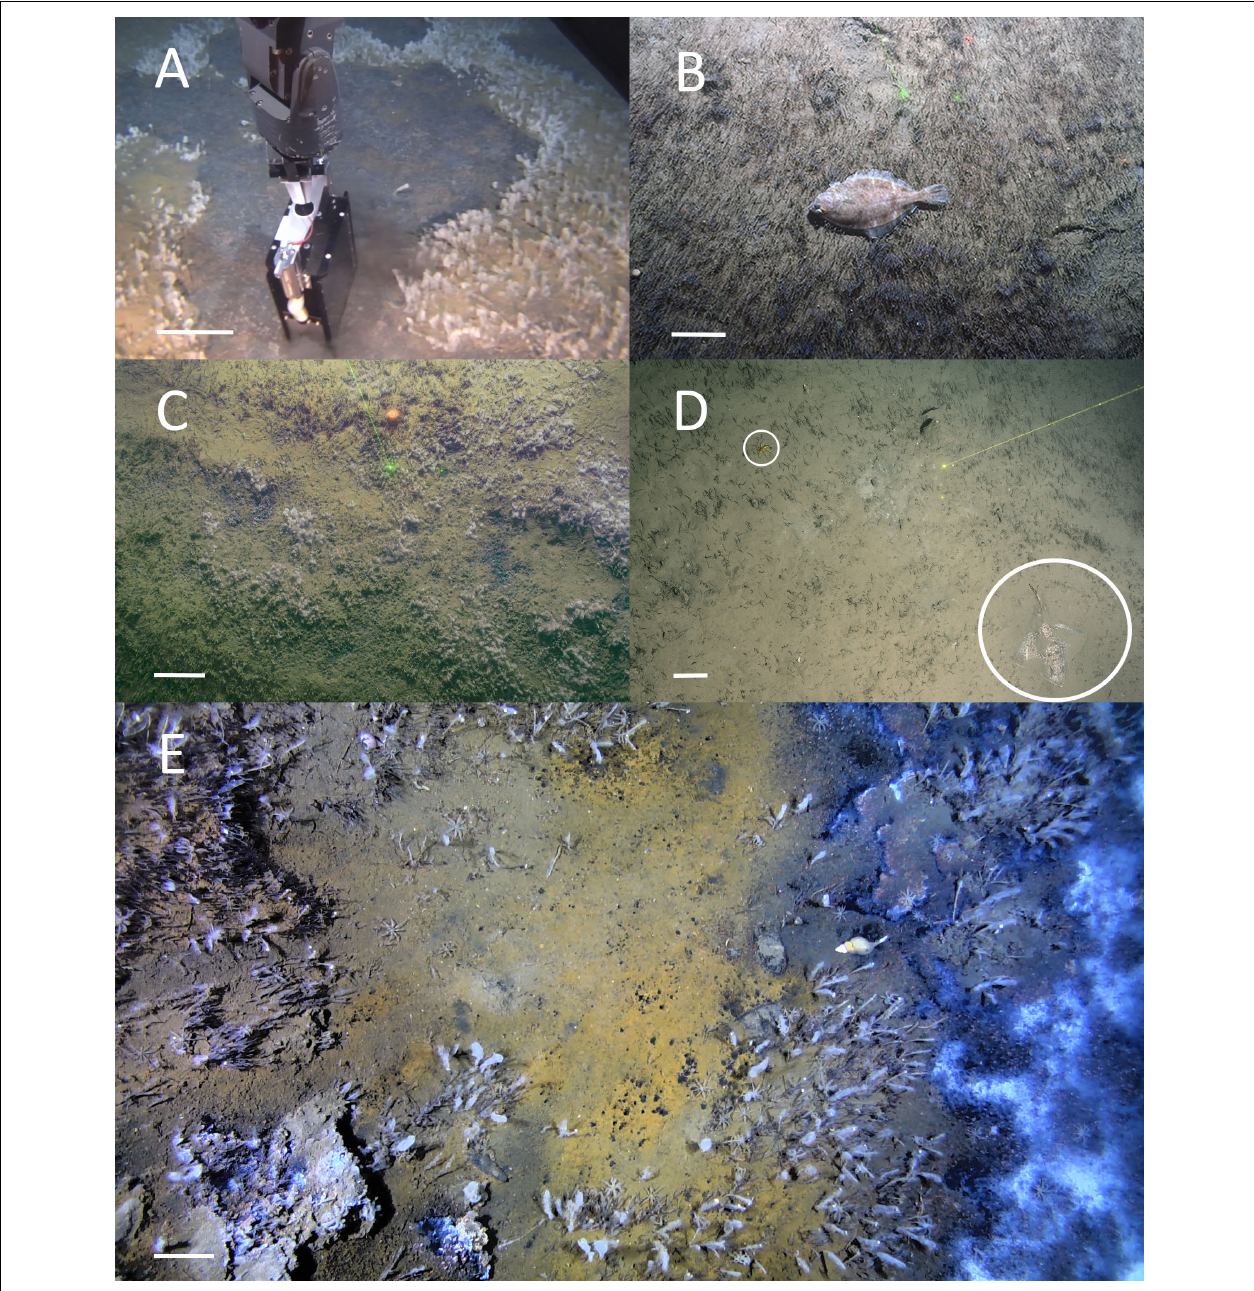
FIGURE 2 | Tufts of siboglinids (mainly Oligobrachia spp.) from different Arctic cold-seep locations. From top left to right: (A) A large siboglinid field covered by filamentous bacteria in the “Bjørnøyrenna crater seep” Barents Sea (330 m) from Åström et al. (2019). (B) An American plaice ( Hippoglossoides platessoides ) in a dense meadow of siboglinids at the Storfjordrenna gas hydrate mounds/pingos, (380 m), from Åström et al. (2016). (C) Siboglinids and filamentous bacteria at the Storfjordrenna seep field (350 m), note also the bright orange anemone in the top middle, from Åström et al. (2019). (D) Siboglinid tufts at the deep Vestnesa seep (Fram Strait, 1,200 m); encircled is a half-buried Arctic skate ( Amblyraja hyperborea ) and a sea spider ( Colossendeis sp.), from Åström et al. (2018). (E) Carbonate outcrops, microbial mats, and filamentous bacteria covering siboglinid tubes at the Lofoten canyon seeps (750 m); note the many sea spiders ( Nymphon hirtipes ) at the bottom, from Sen et al. (2019b). Scale bars indicate 20